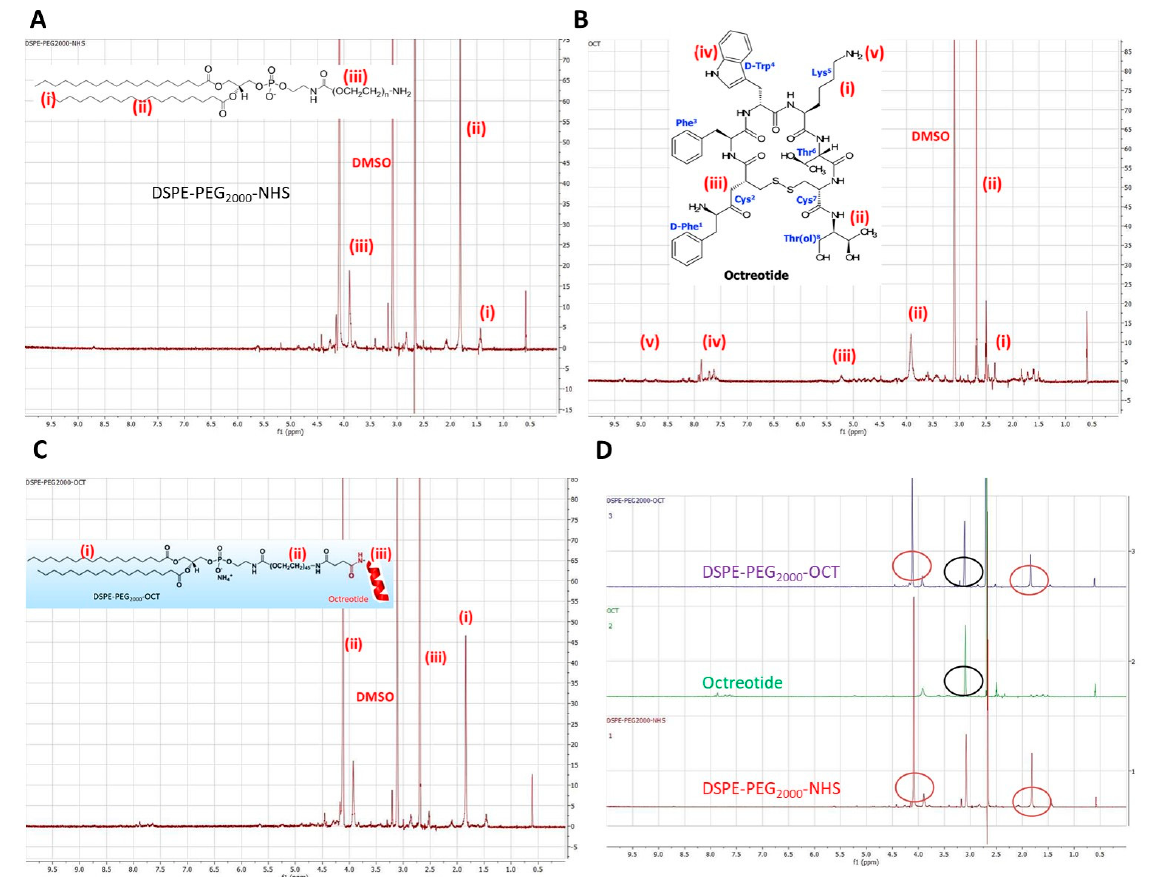
Figure 2. 1 H NMR spectrum of ( A ) DSPE-PEG 2000 -NHS, ( B ) OCT, ( C ) DSPE-PEG 2000 -OCT and ( D ) stacked spectrum of DSPE-PEG 2000 -OCT, OCT and DSPE-PEG 2000 -NHS.